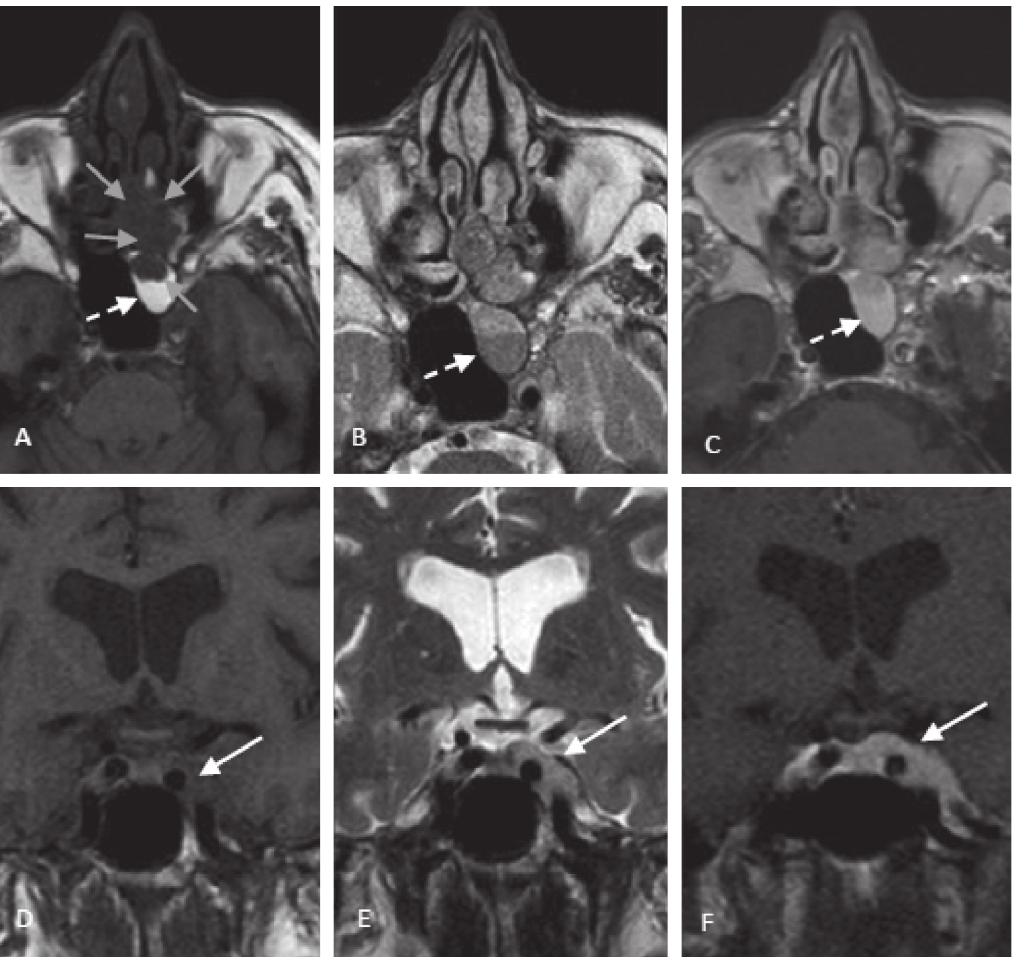
Figure 2: Initial MRI images: (a, c) axial and coronal T1WI, (b, e) axial and coronal T2WI, and (c, f) axial and coronal T1WI after gadolinium intravenous administration. The left nasal, ethmoidal, and sphenoidal lesion (grey arrows) can be seen with cavernous extension (solid white arrows), with low signal on T1WI and T2WI and homogeneous enhancement after contrast administration, with sinus obstruction and retention of secretions in ethmoid and sphenoid sinuses (dashed white arrows). MRI, magnetic resonance imaging; WI, weighted